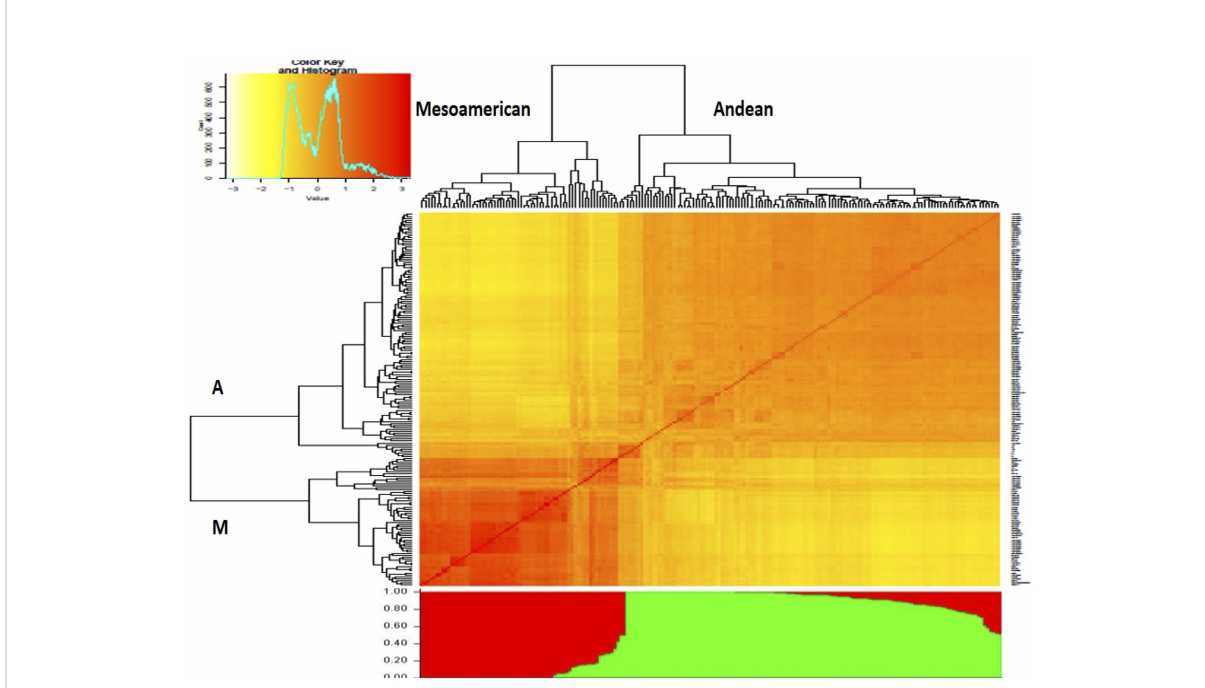
FIGURE 4 Dendrogram clustering 192 Phaseolus vulgaris accessions based on the genetic distances (above) and structure analysis bar plot (below). Both analyses divide the panel into two subgroups, designated “ A ” and “ M ” , representing the Andean and Mesoamerican clades,